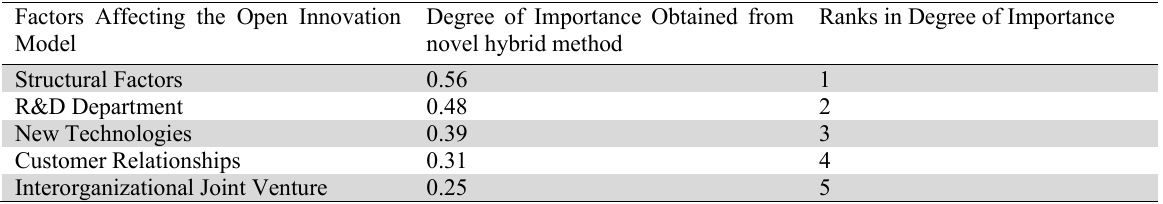
The final rank of the factors Factors Affecting the Open Innovation